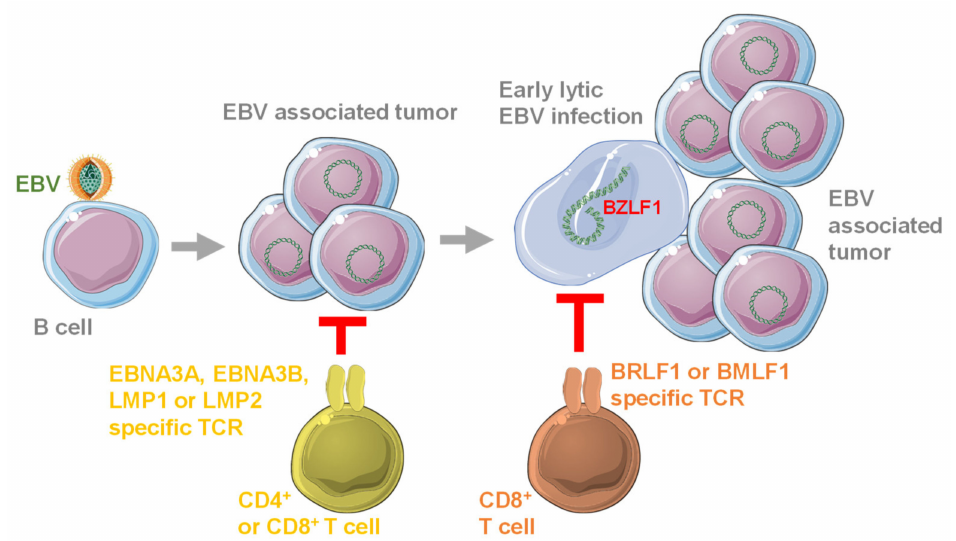
Figure 2. Available EBV specific T cell receptors (TCRs) target di ff erent stages of EBV infection and associated tumorigenesis. EBV transforms B cells after infection, by establishing latent viral